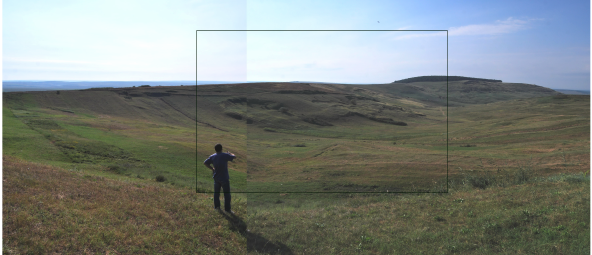
Fig. 4. Semicircular depression shaped by complex geomorpholog- ical processes ( hârtop in the Moldavian Plateau, ¸Sipote